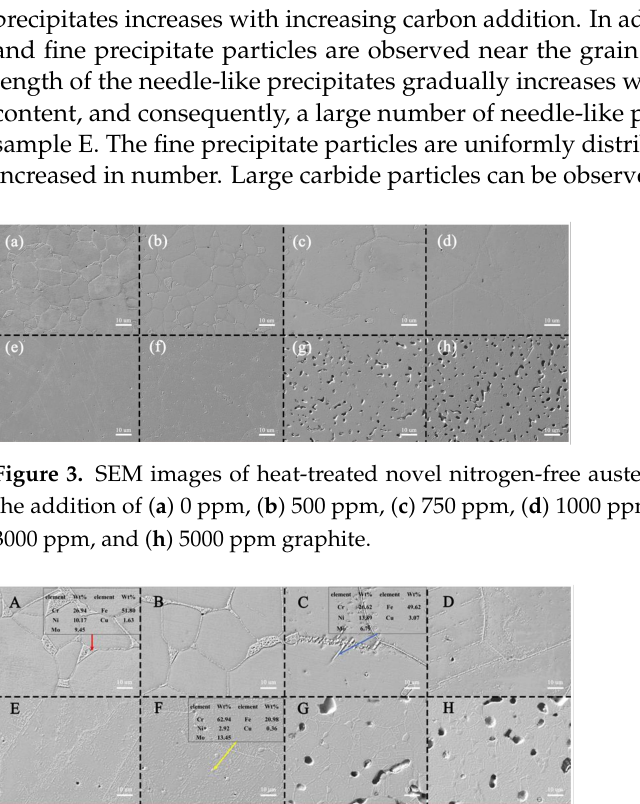
Figure 4. Precipitate morphology of heat-treated novel nitrogen-free austenitic stainless steel samples with the addition of ( A ) 0 ppm, ( B ) 500 ppm, ( C ) 750 ppm, ( D ) 1000 ppm, ( E ) 1500 ppm, ( F ) 2000 ppm, ( G ) 3000 ppm and ( H ) 5000 ppm graphite.